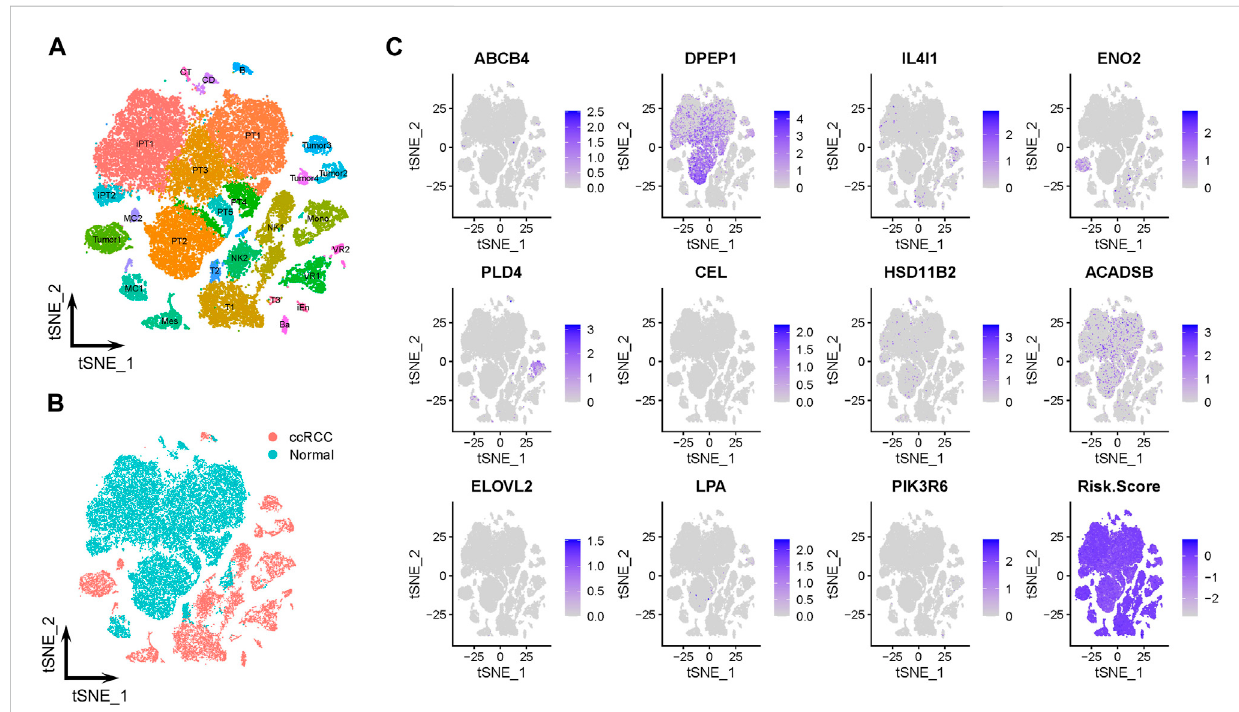
FIGURE 6 Prognostic expression pro fi le based on single-cell sequencing analysis. (A, B) Composition and distribution of single cells from GSE131685 and GSE171306 datasets. (C) Expression pro fi les of ABCB4 , DPEP1 , IL4I1 , ENO2 , PLD4 , CEL , HSD11B2 , ACADSB , ELOVL2 , LPA , and PIK3R6 , and risk scores for each cell. t-SNE, t-distributed stochastic neighbor; Im., immune; Epi., epithelial; Endo., endothelial; Mes, mesenchymal; CD, collecting duct; CT, connectingtubule;iEn,injuredendothelialcells;Fib, fi broblast;Mast,mastcell;MC,macrophage;Mono,monocyte;PT,proximaltubule;iPT,injured proximal tubule; VR, vasa